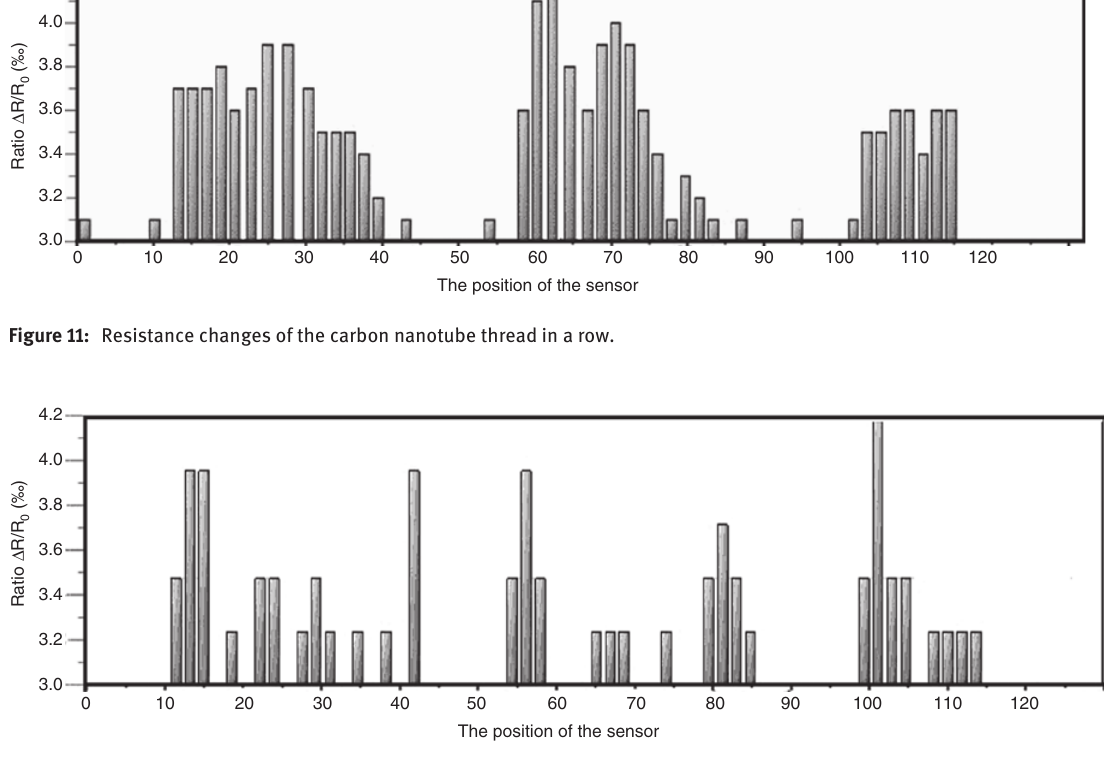
Figure 12: Resistance changes of the carbon nanotube thread in a